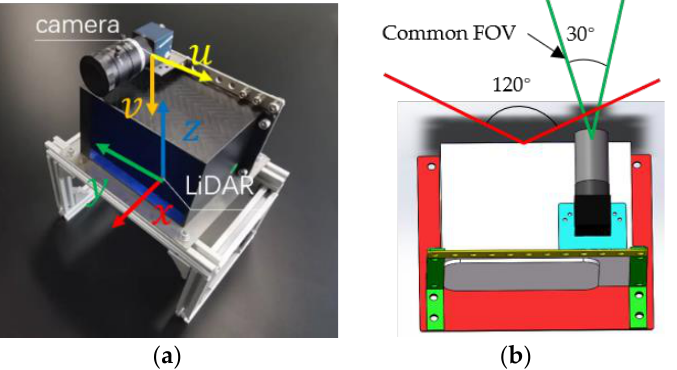
Figure 8. Setup of proposed method. ( a ) is the coordinate system definition, and ( b ) is the common FOV of two sensors.